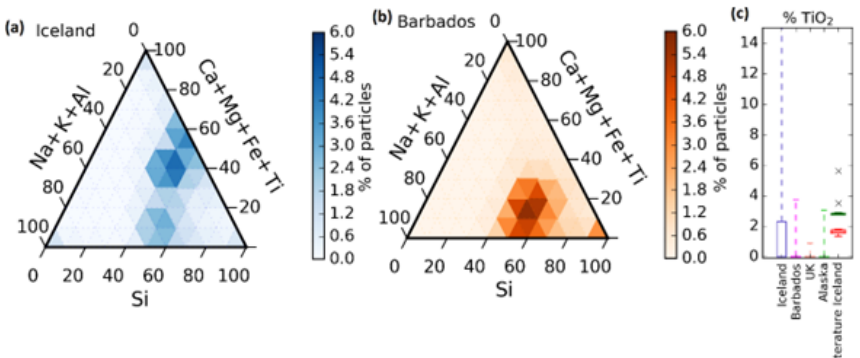
Figure 10. Ternary graphs of the chemical composition of Icelandic dust particles (a) and Saharan dust particles collected in Barbados (b) . Each graph contains a heat map with the percentage of dust particles in each sample compositional bin. The chemical composition of each aerosol has been recalculated from the weight percentages given by the SEM software, excluding elements that are not Si, Al, Fe, Mg, Ca, Na, K, Ti, Mn, and P. (c) The box represents particles in the Q3 percentile of the percentage of the composition of Ti in all the dust particles in each sample (Icelandic dust, Saharan dust collected in Barbados, dust collected in the UK, and dust collected in Alaska). The whiskers represent the composition of all particles between the median plus and minus 2 standard deviations. The data have been compared to the Ti weight percentage of different Icelandic dust and ash samples from the literature. (Figure extracted from the Supplement of Sanchez-Marroquin et al., 2020.)